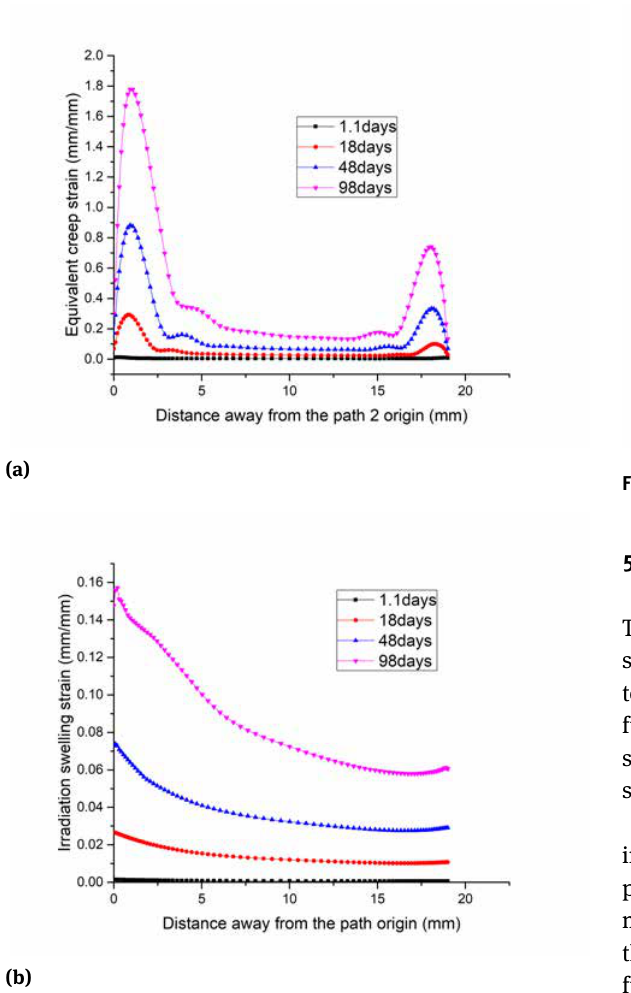
Figure 15: The evolution of (a) equivalent creep strains and (b) irra- diation swelling strains along Path 2